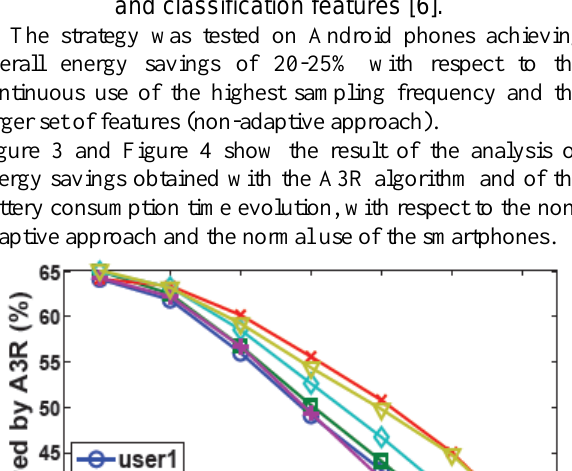
Figure 4 . Power consumption of different